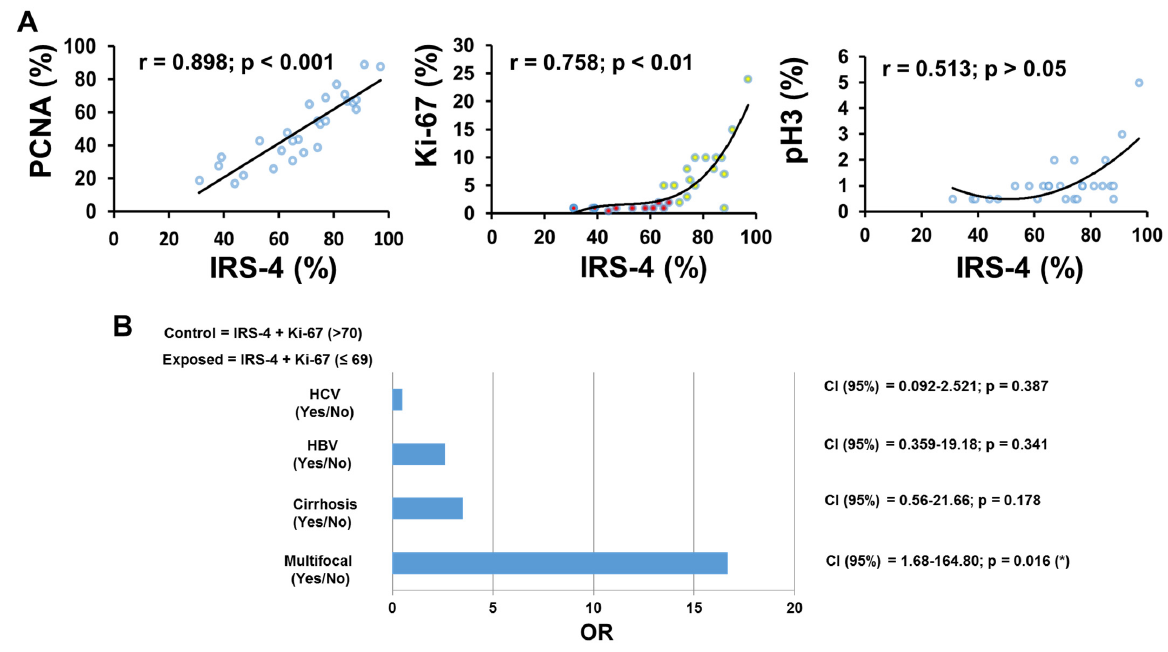
Figure 4. Relation between the percentage of IRS-4 compared with percentage of PCNA, Ki-67, and pH3 ( A ). Percentage of IRS-4 expression as a function of PCNA, Ki-67, and pH3. ( B ). Odds ratio of P1 (exposed-red points) and P2 (control-yellow points) groups as defined in the Results section. p < 0.05 (*)